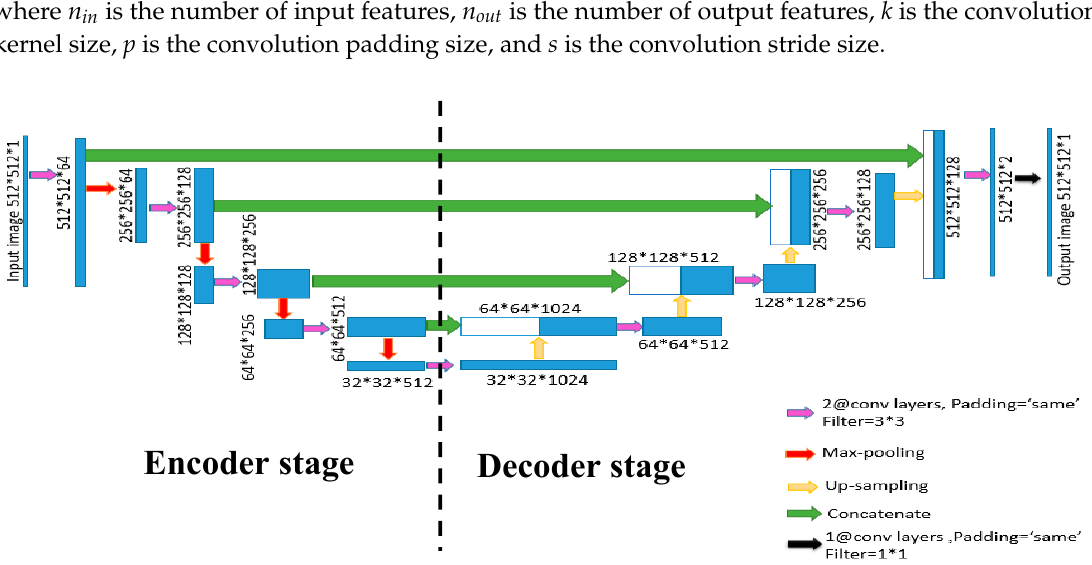
Figure 3. U-Net architecture and the parameters used in the proposed algorithm. Each box contains an n* n* k input and 2@Conv layers (which means that two consecutive convolution Layers are applied). The left-hand side is the contraction path (Encoder), where we apply regular convolutions and max-pooling layers, and the right-hand side is the expansion path (Decoder) where we apply transposed convolutions along with regular convolutions.